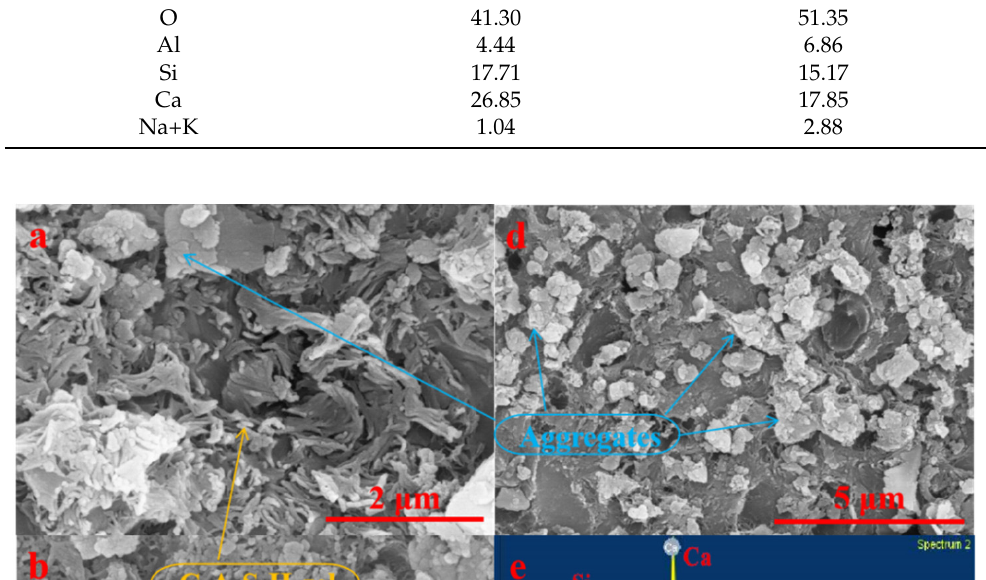
Figure 6. SEM morphology ( a , b ) and EDS analysis ( c ) of C-A-S-H gels in the AACM after 28 days of hydration.